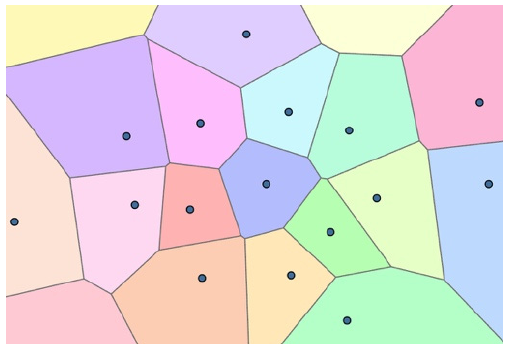
Figure 6. Thiessen polygons based on randomized